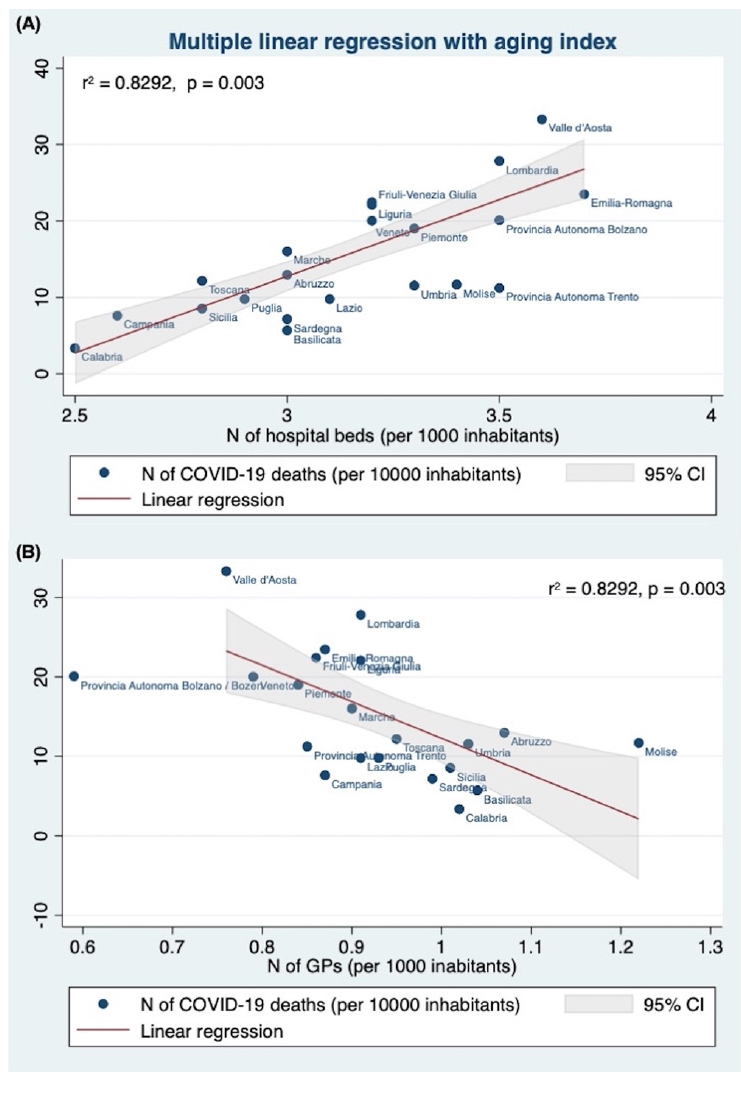
Figure 3. Multiple linear regression among the number of COVID-19 deaths (×10,000 inhabitants) and ( A ) the number of hospital beds (×1000 inhabitants), and ( B ) the number of GPs (×1000 inhabitants) per Italian region. In a multivariate linear regression analysis, introducing the number of COVID-19 deaths (per 100,000) as the dependent variable and the aging index, the number of hospital beds (per 1000), the health expenditure per capita, the GPs per 1000, and the number of LTCF significantly as the independent variable, the number of hospital beds (per 1000) ( β = 15.55866, p = 0.003) and the number of GPs (per 1000 inhabitants) ( β = − 34.8603, p = 0.003) significantly predicted the number of COVID-19 deaths (×10,000 inhabitants). The Italian regions with a higher number of hospital beds (×1000 inhabitants) and a lower number of GPs showed a higher COVID- 19 death rate. The line shows the linear regression value obtained by the multivariate analysis.